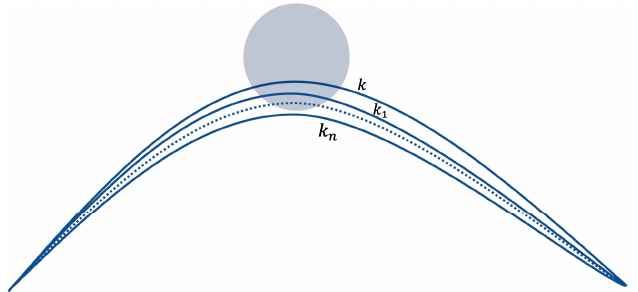
Figure 7. Schematic diagram of the reduced curvature obstacle avoidance algorithm. The flowchart of the smoothing optimization algorithm is shown in Figure 8.